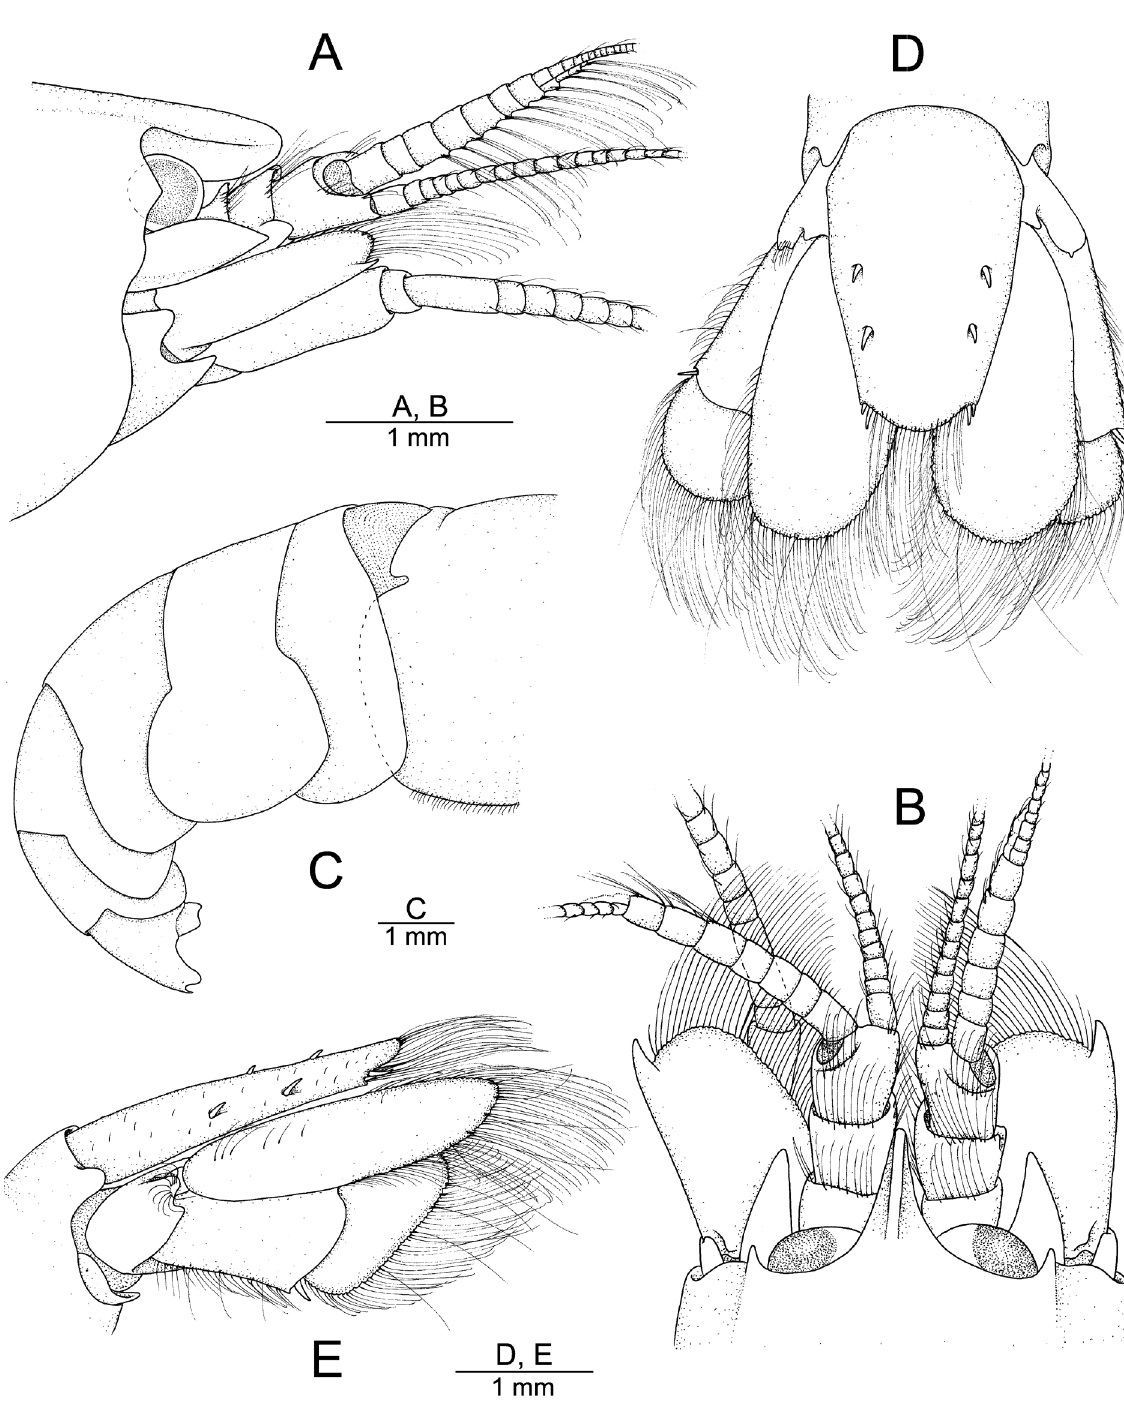
Fig. 1. Aretopsis sandybrucei sp. nov., holotype, ♂ (cl 5.31 mm) from Capel Bank, Coral Sea (MNHN-IU-2017-2924). A . Anterior part of carapace and right cephalic appendages, lateral view. B . Same, dorsal view. C . Pleon, lateral view. D . Posterior portion of sixth pleonite, telson and uropods, dorsal view E . Telson and left uropod, lateral